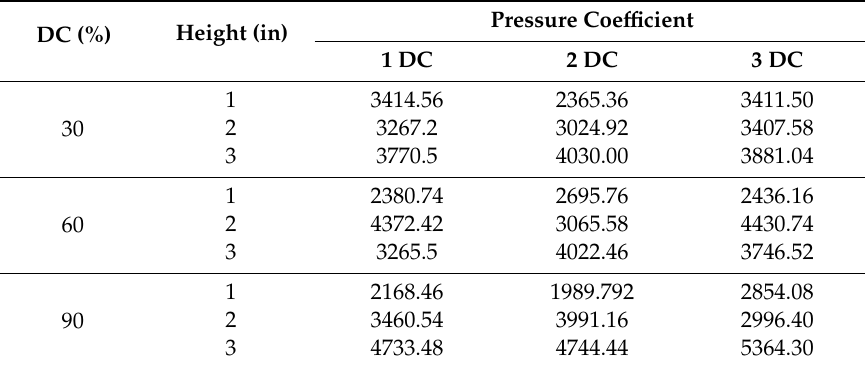
Table 5. Pressure coe ffi cient ( π 3 ) at di ff erent dynamic